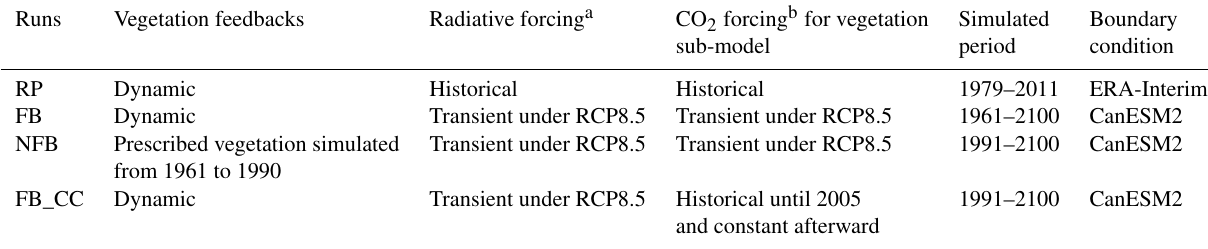
Table 1. Experimental design for the investigation of the vegetation–climate feedbacks in this study. Runs Vegetation